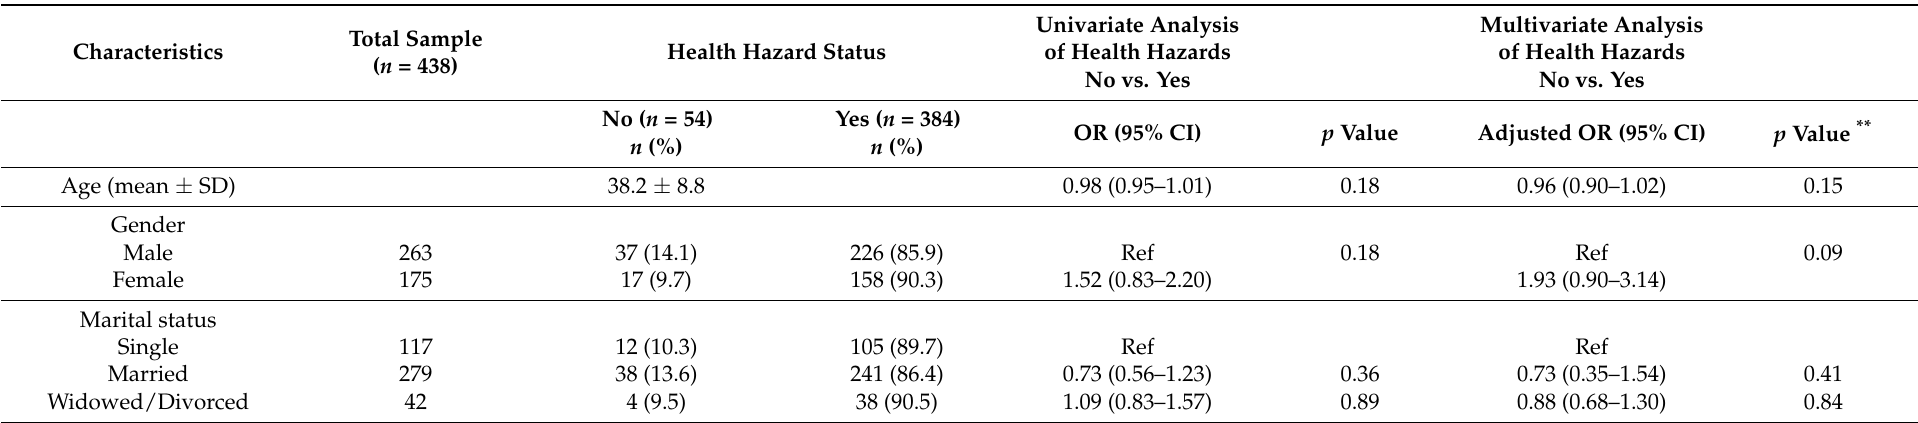
Table 4. Non-biological health hazards and their association with socio-demographic and lifestyle-related